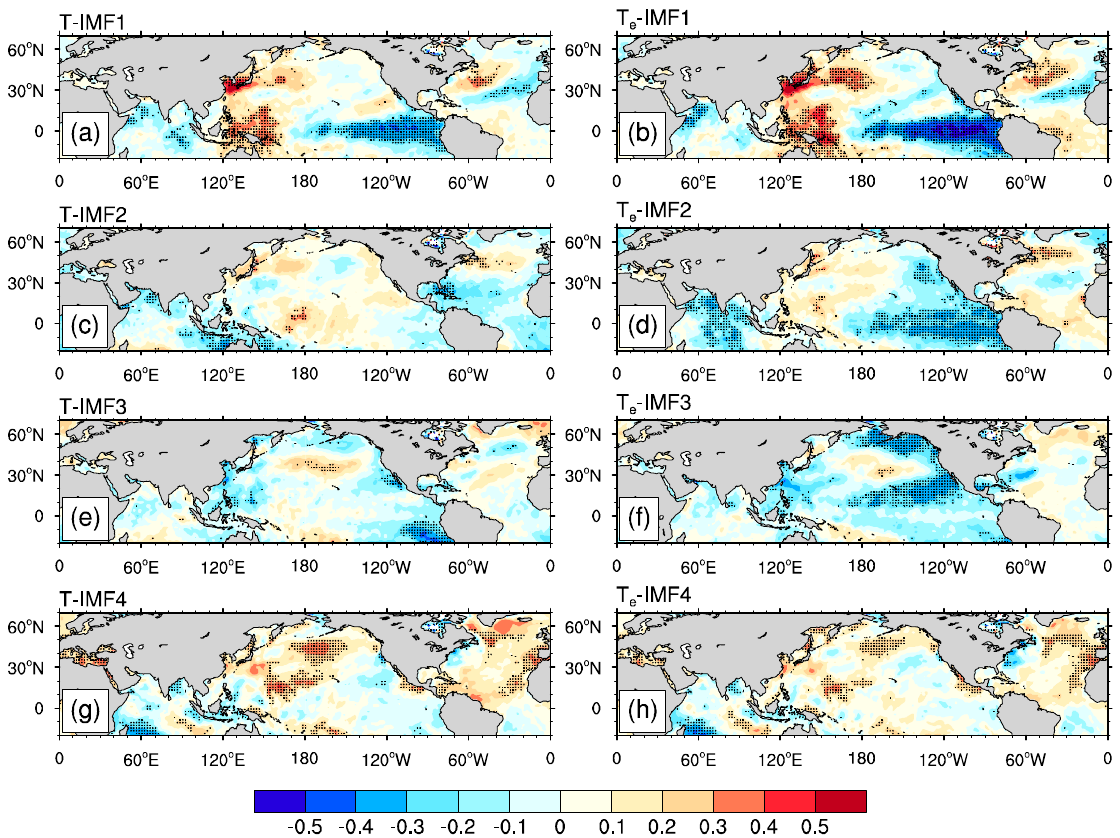
Figure 8. The spatial distributions of correlation coefficients between summer sea surface temperatures (SSTs) and the principal components of the first REOF mode of the IMFs (Left panel: T ; Right panel: T e ). ( a , b ) IMF 1; ( c , d ) IMF 2, ( e , f ) IMF 3, ( g , h ) IMF 4. Black dots represent the correlation coefficients that are statistically significant at 5% level.